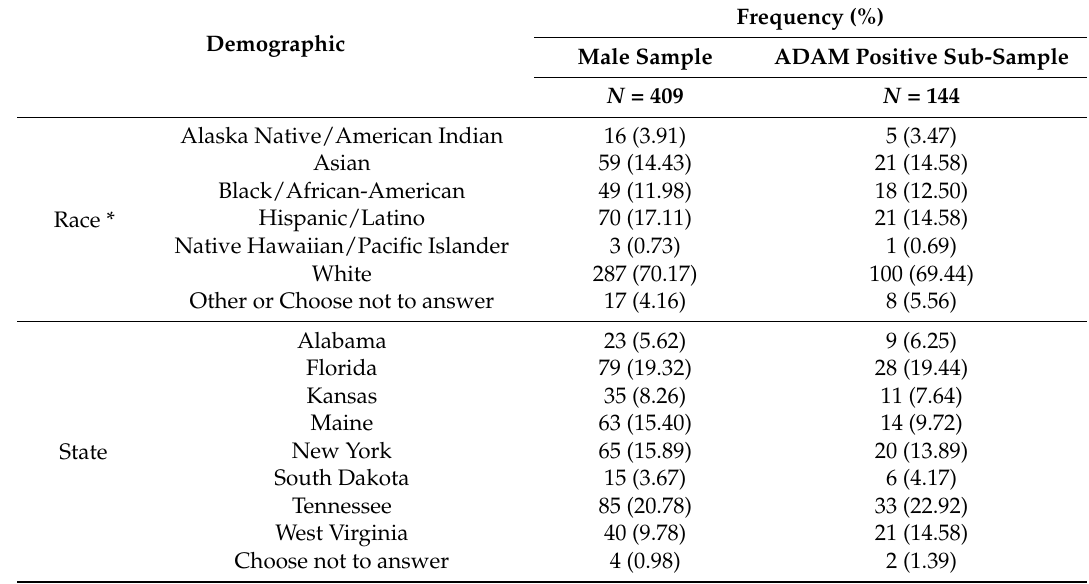
Table 1. Demographics. Race, and state of the overall sample and the ADAM-positive sub-sample.